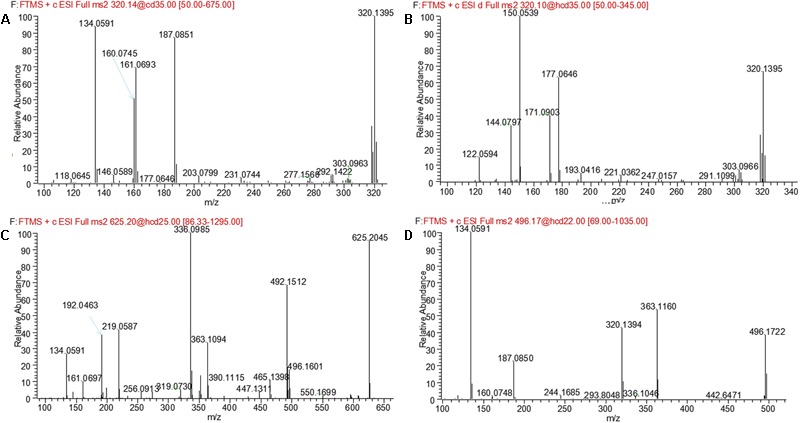
MS2 spectra of M1 (A), M2 (B), M3, and M4 (C), and M5 (D).